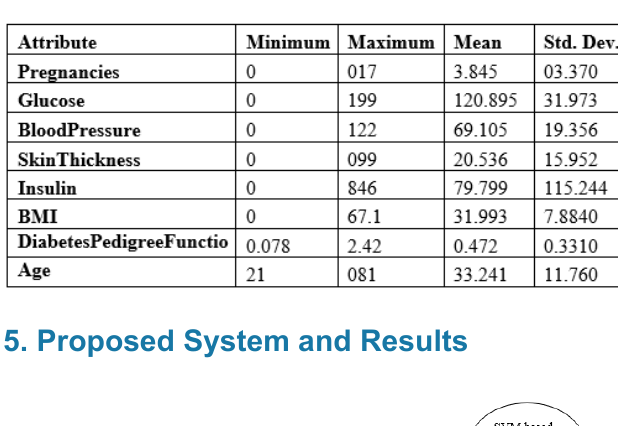
Table 2. Dataset Statistics